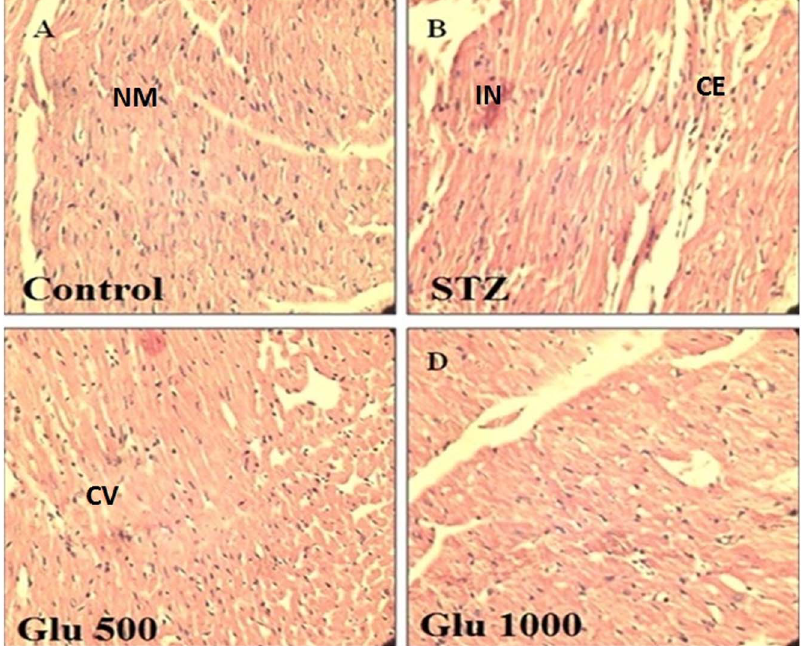
Figure 2. Histopathology of rat heart by hematoxyline and Eosin staining. NM= normal myocardium, CE= cytoplasmic eosinophilia, IN = mycardial inflammation, CV= cytoplasmic vacuolization. (A) Non-diabetic control, (B) Diabetic control group, (C) L-glutamine (500 mg/kg) and (D) L- glutamine (1000 mg/kg).